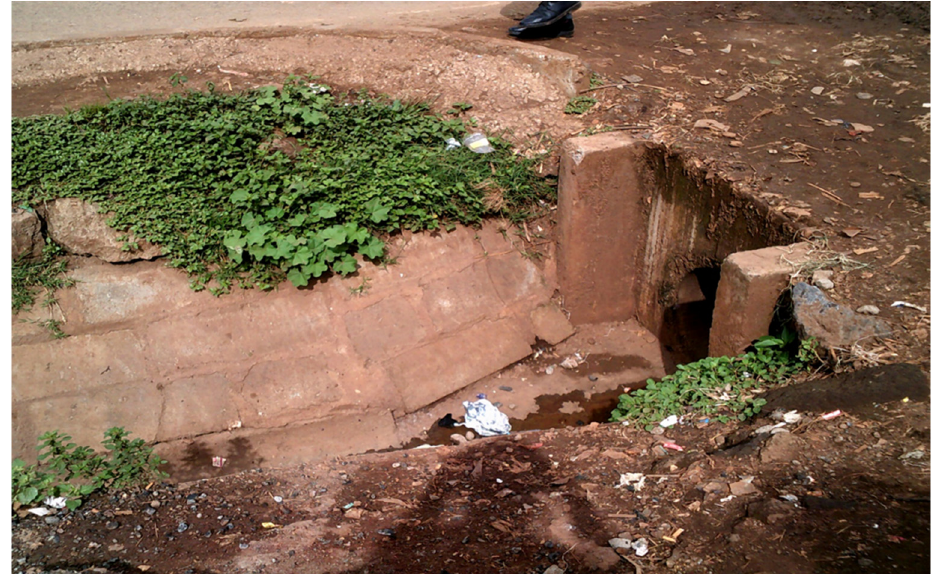
Figure 1. A trench that reminded the participant where an LGBTI individual was killed and dumped in 2019.